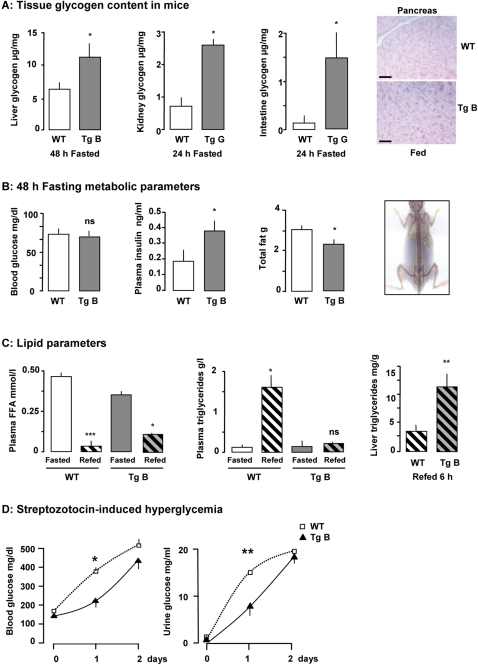
Detection of low and high glucose levels.A: Left panel: glycogen content in liver, kidney and intestine from fasting wild-type (WT) and transgenic (Tg) mice. Values are presented as means±S.E.M. (for the liver n = 6 to 7 mice per group, for the kidney and intestine n = 3 mice/group). Statistical differences between transgenic and wild-type mice are indicated as *P<0.05. Right panel: Representative pancreas sections from fed wild-type and transgenic mice stained with PAS reagent. The black bar corresponds to 50 µm. B: Fasting metabolic parameters. Blood glucose concentration, plasma insulin concentration and total fat are indicated for wild-type and transgenic mice after fasting for 48 h. Values are presented as means±S.E.M. (n = 4 mice/group). Statistical differences between transgenic and wild-type mice are indicated as *P<0.05 and ns non significant. Right panel: Example of a DEXA scan. C: Lipid metabolism. Plasma free-fatty acids (FFA) and triglyceride concentrations in wild-type and transgenic mice in the fasting state or 6h after refeeding. Values are presented as means±S.E.M. (n = 3 to 5 mice/group). Statistical differences between refed and fasted mice are indicated as ***P<0.001, *P<0.05 and ns non significant. Right panel: Liver triglyceride content in liver extract from wild-type and transgenic mice 6h after refeeding. Values are presented as means±S.E.M. (n = 4 to 5 mice/group). Statistical differences between transgenic and wild-type mice are indicated as **P<0.01. D: Blood glucose and urine glucose levels measured after steptozotocin injection. Values are presented as means±S.E.M. (n = 3 to 4 mice/group). Statistical differences between wild-type (open squares) and transgenic (closed triangles) mice are indicated as *P<0.05, **P<0.01.